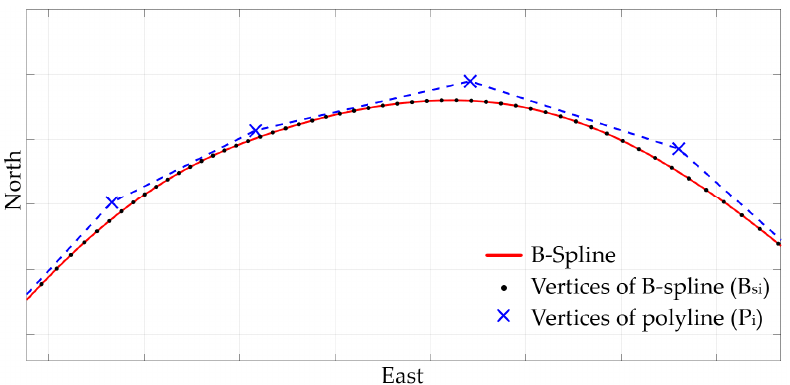
Figure 5. B-spline interpolation.